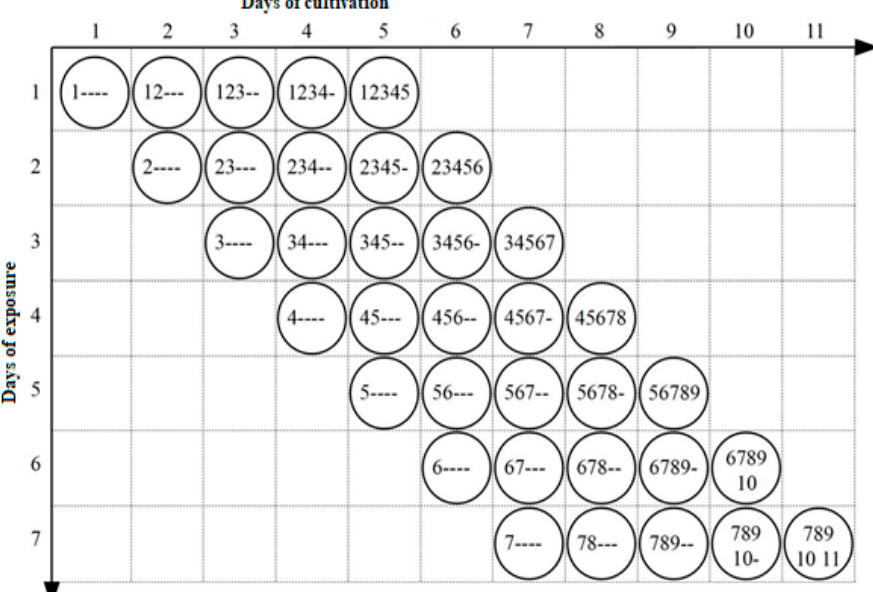
Figure 1. Scheme of time-dependent exposure to non-thermal plasma. Numbers denote the day of exposure; symbol ‘-’ indicates no further exposure.